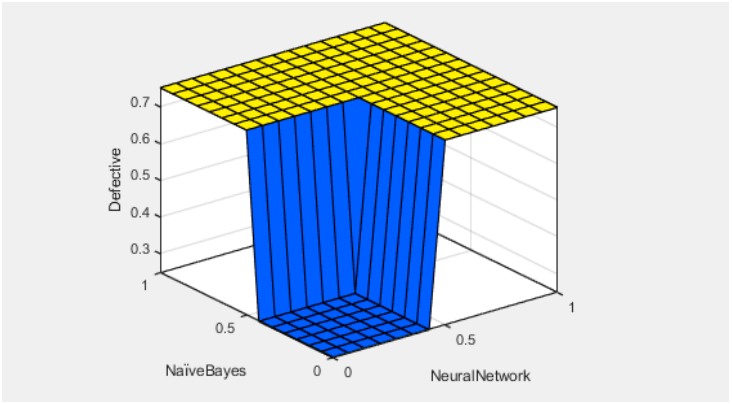
Figure 2. Rule surface of the proposed fuzzy logic-based fusion technique with NB and ANN.